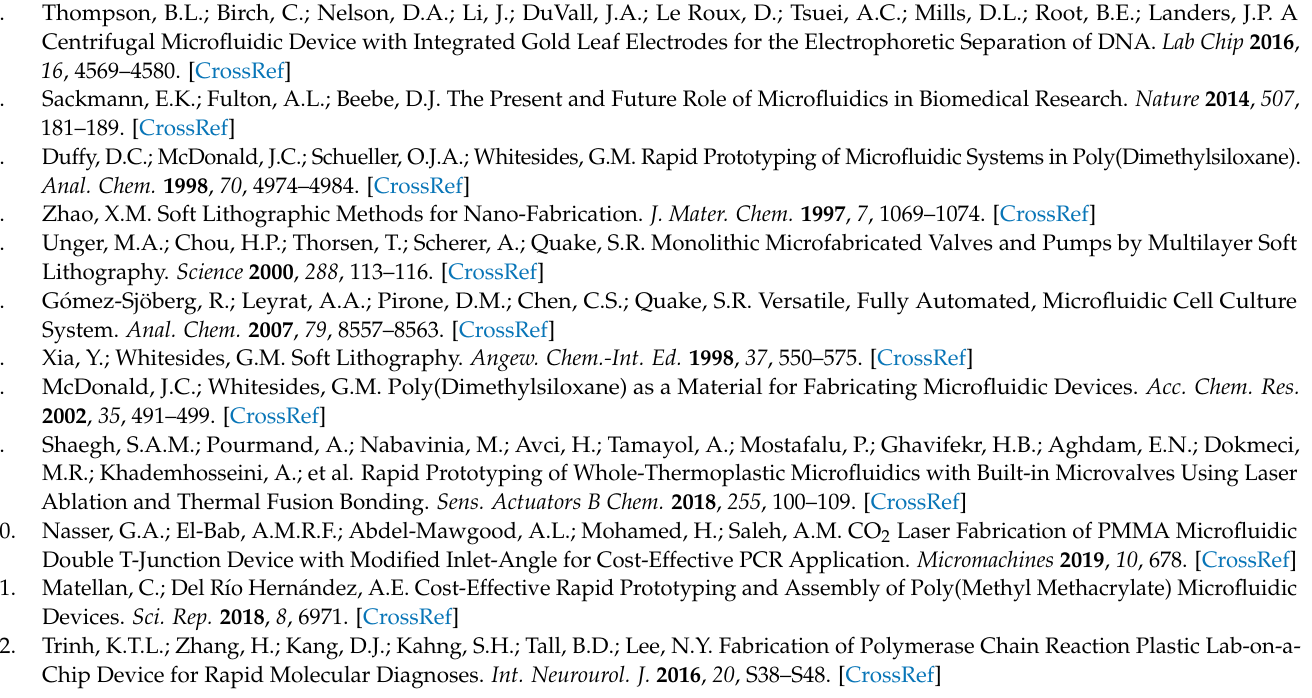
Figure S6: Fluorescence images acquired at 3-day (a1), 7-day (a2), post-cultivation in the bioreactor, 8-day after bacteria re-suspended in the same bioreactor (b) and plotted growth curve (c); Figure S7: Leakage photos of PbLT-fabricated bioreactor. Table S1: The thickness of (1) received Parafilm ® , (2) Stretched Parafilm ® , and (3) Parafilm ® after bonding; Table S2: Comparison of PbLT and conventional bonding methods. References [28,29] are cited in Supplementary